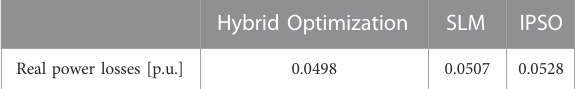
TABLE 3 Values of real power losses optimized by the hybrid optimization, SLM, and IPSO. Hybrid